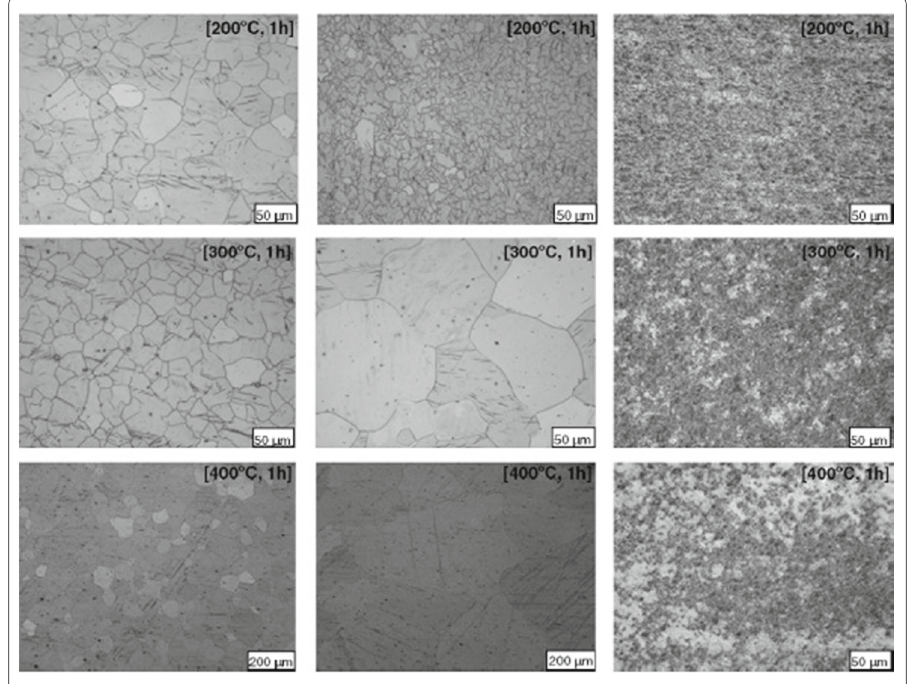
Fig. 9 Micro-structural images of the stir zone after the heat treatment